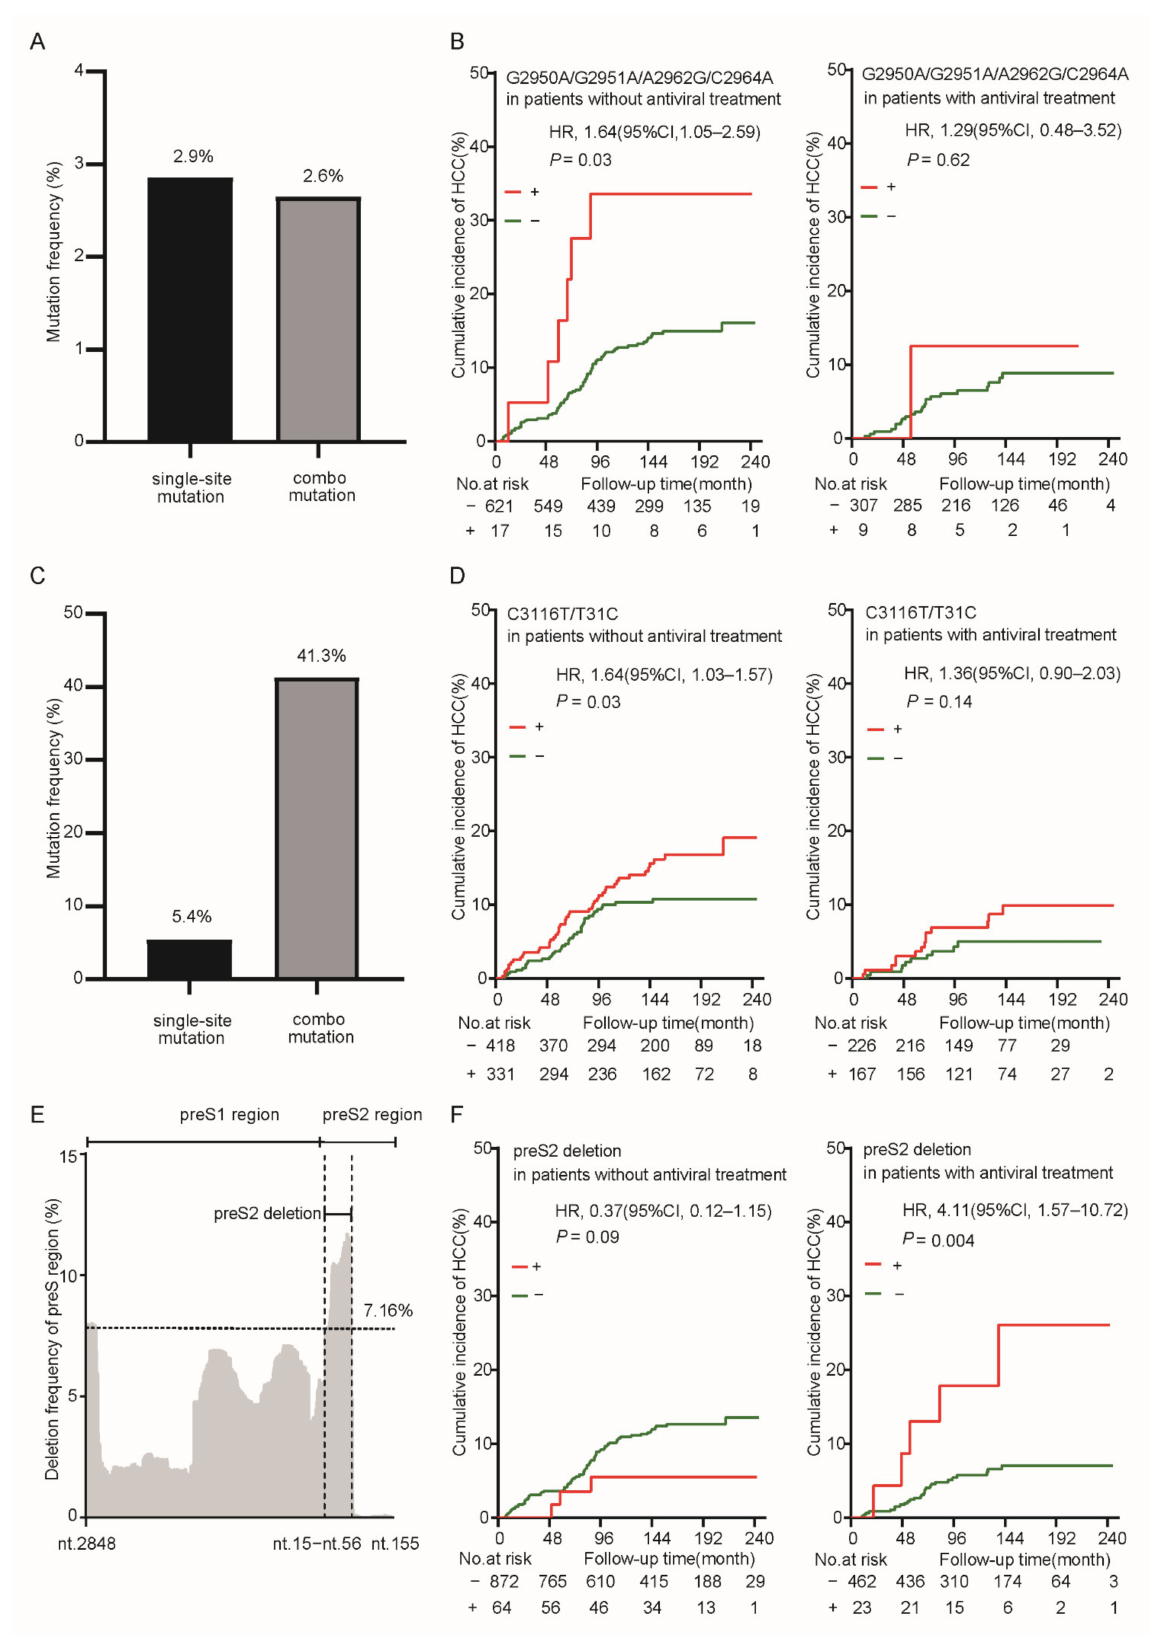
Figure 1. The impact of baseline preS mutations on HCC occurrence in a prospective cohort study with 2114 HBV-infected patients. ( A ) The frequencies of G2950A, G2951A, A2962G, and